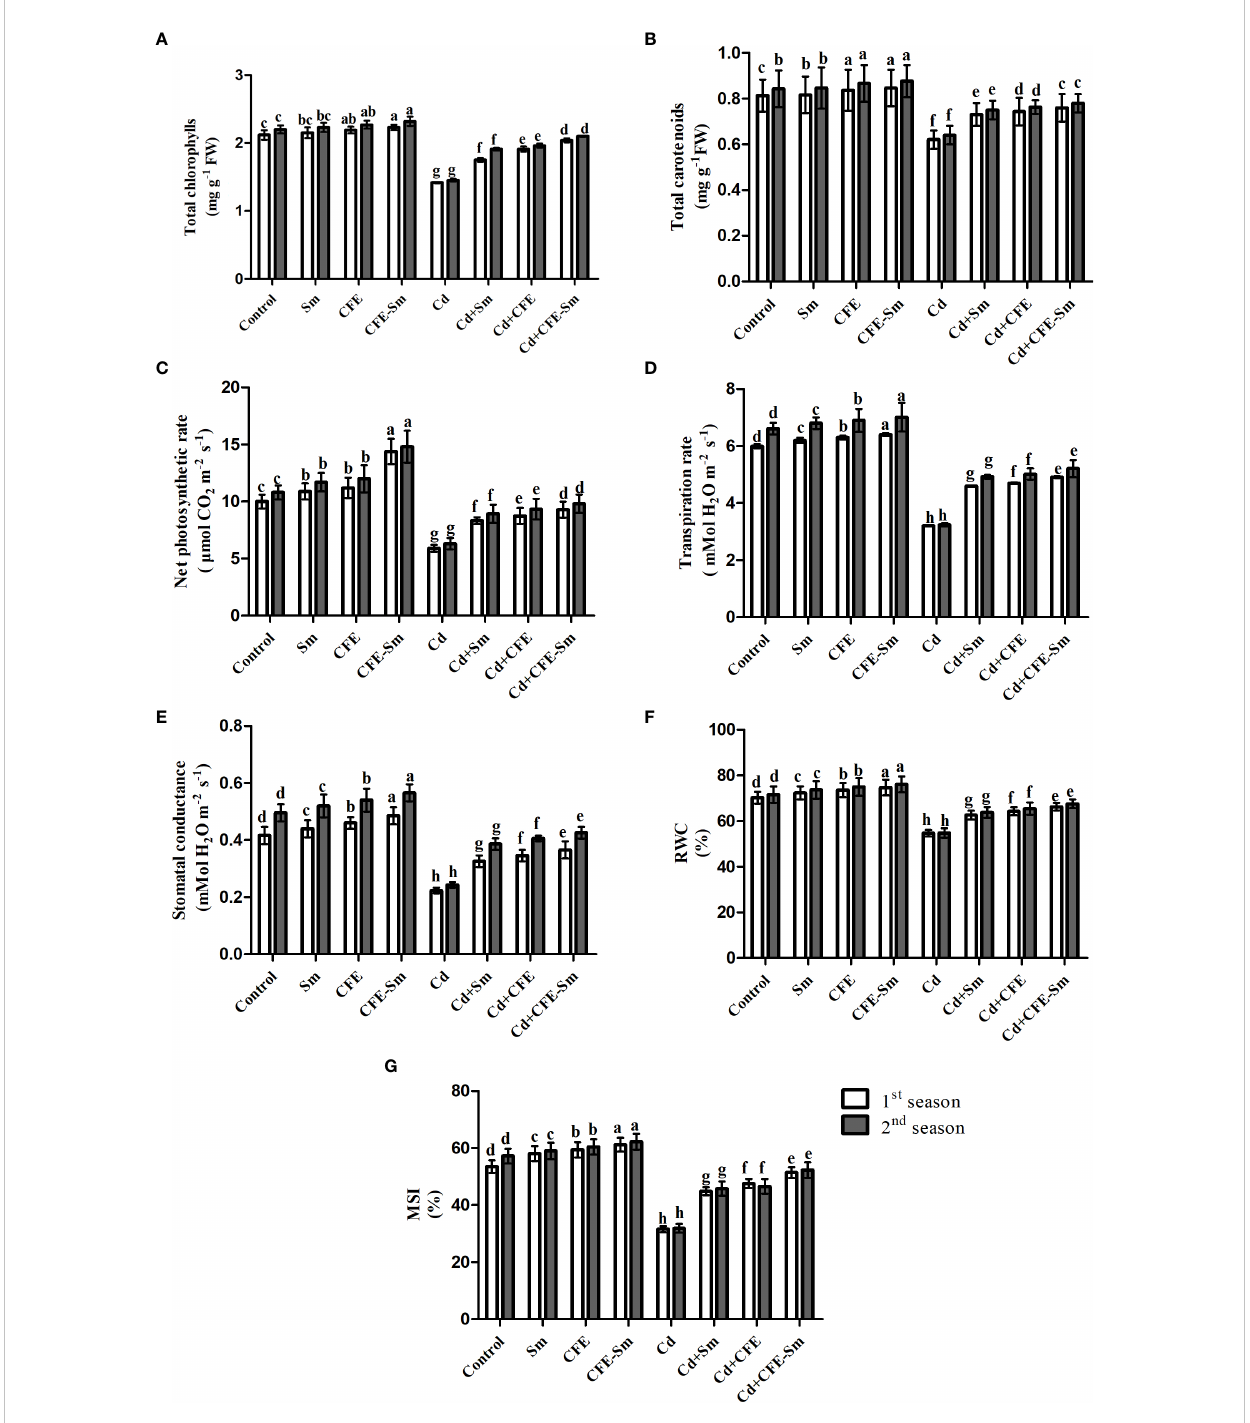
FIGURE 1 Physiological parameters of the wheat plant under Cd stress after foliar application of silymarin (Sm), clove fruit extract (CFE), or silymarin-enriched clove fruit extract (CFE-Sm). (A) total chlorophylls, (B) total carotenoids, (C) net photosynthetic rate, (D) Pn; transpiration rate (Tr); (E) Stomatal conductance (Gs), (F) relative water content (RWC), and (G) membrane stability index